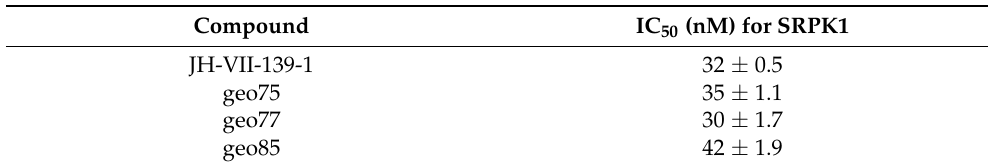
Table 2. Half-maximal inhibitory activity (IC 50 ) of JH-VII-139-1, geo75 , geo77 and geo85 over SRPK1. Results are presented as mean ± SD of three independent experiments.